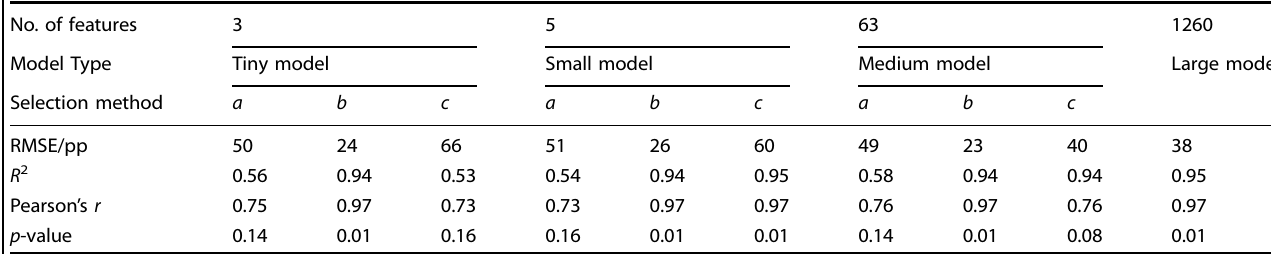
Table 2. Statistics on the representative validation